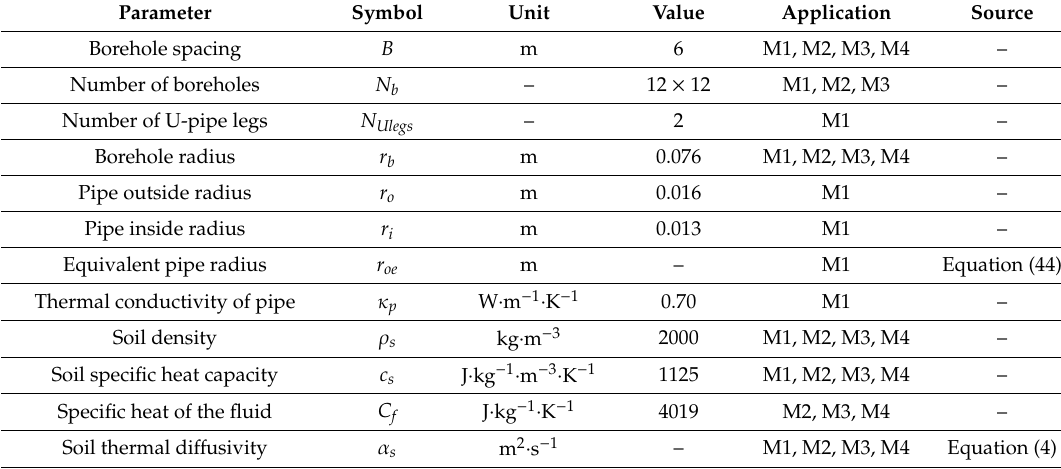
Table 3. Parameter values for comparison